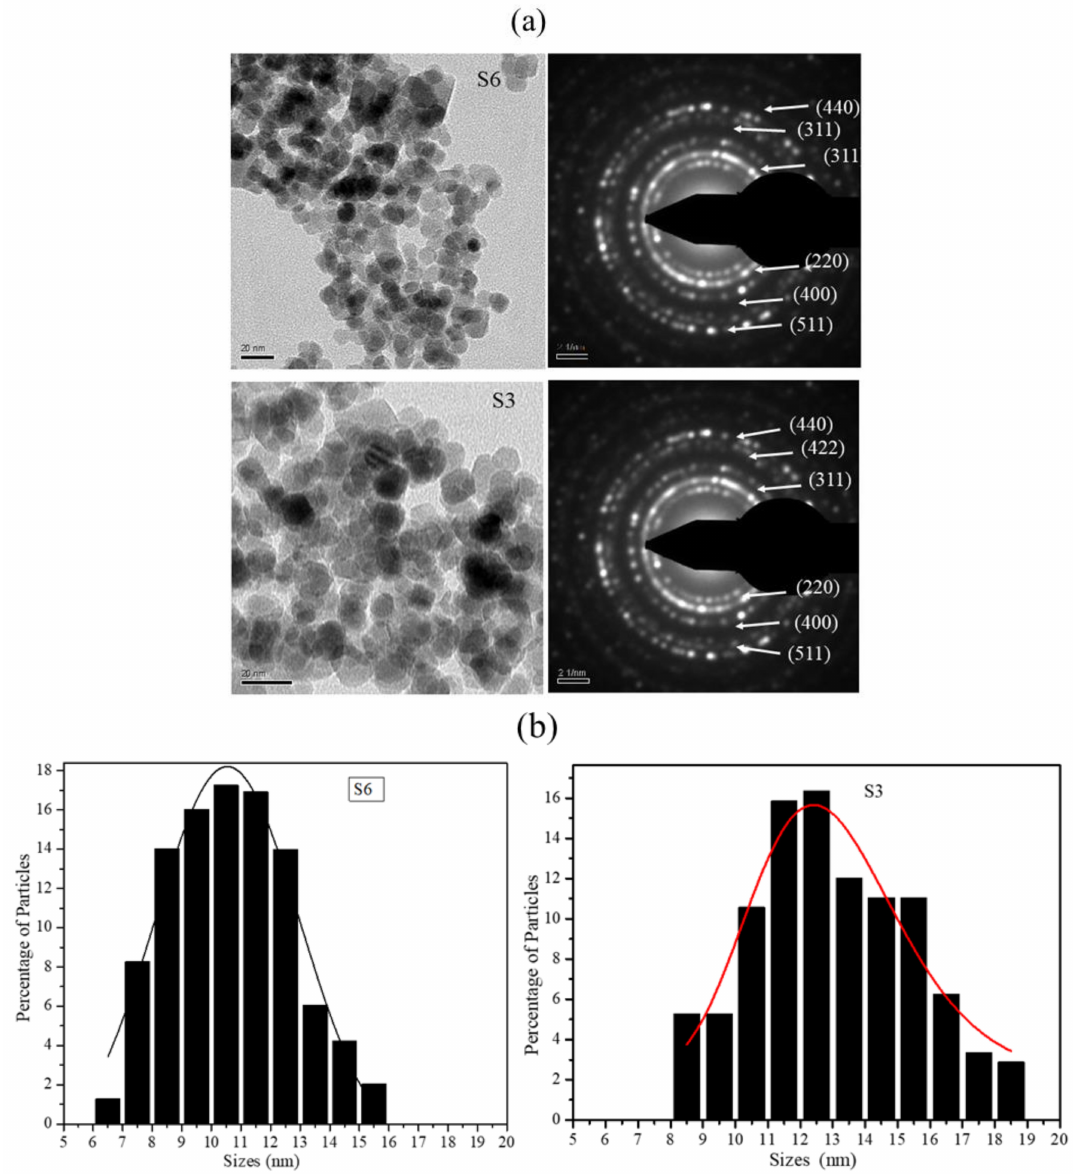
Figure 3. ( a ) TEM images and selected area electron diffraction patterns of batches S6 and S3 of Fe 3 O 4 nanoparticles. ( b ) Size distribution histogram for S6 and S3 nanoparticle